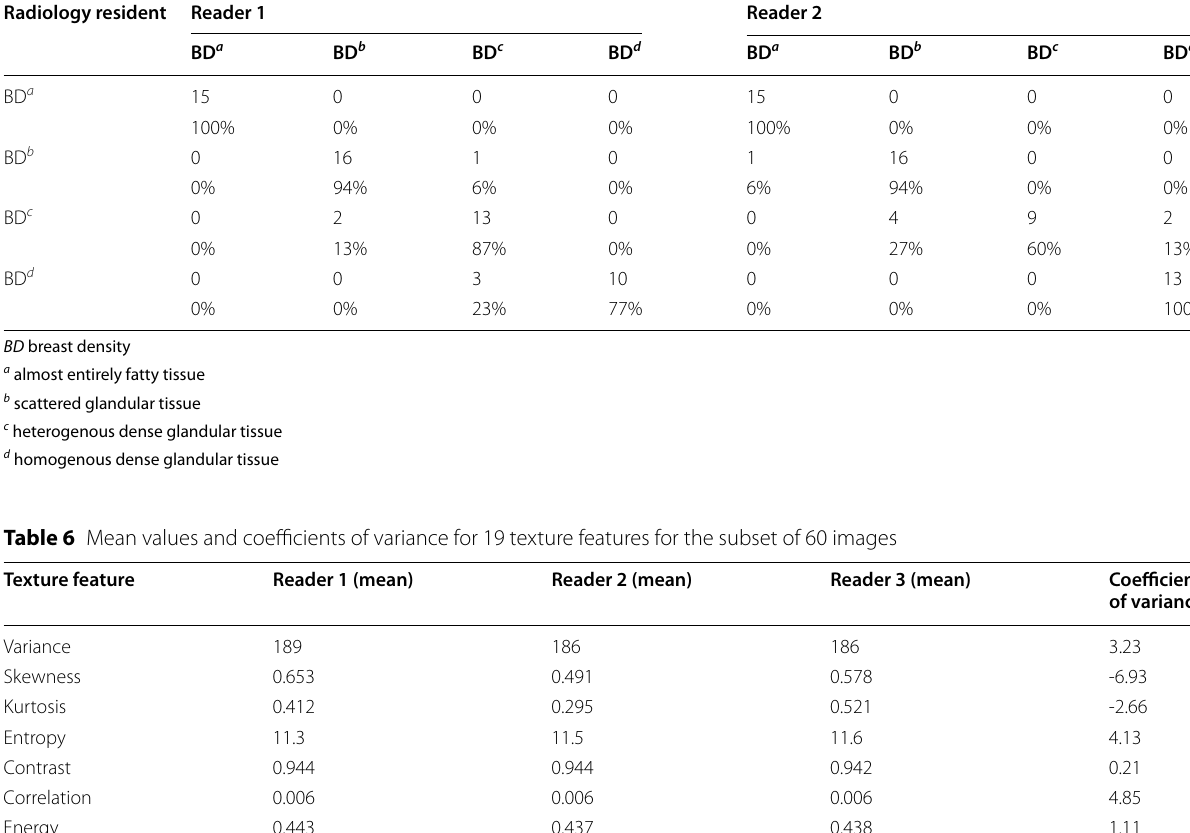
Table 5 Breast density assessment ( a–d ) for 60 representative breast-CT images, performed by two readers (1: J.W.; 2: A.B.), compared to classification given the radiology resident (A.L.)